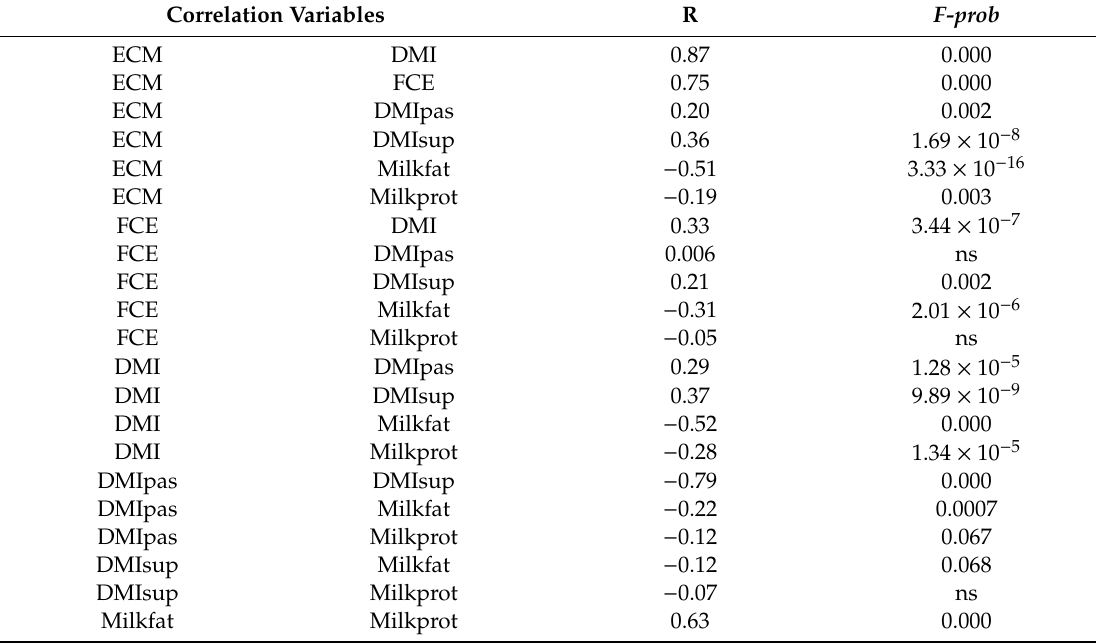
Table 6. Pearson correlation coe ffi cient and statistical significance ( F-prob ) for correlations between milk production and intake parameters for lactating dairy herds on 43 grazing system dairy farms. Correlation Variables R F-prob ECM DMI